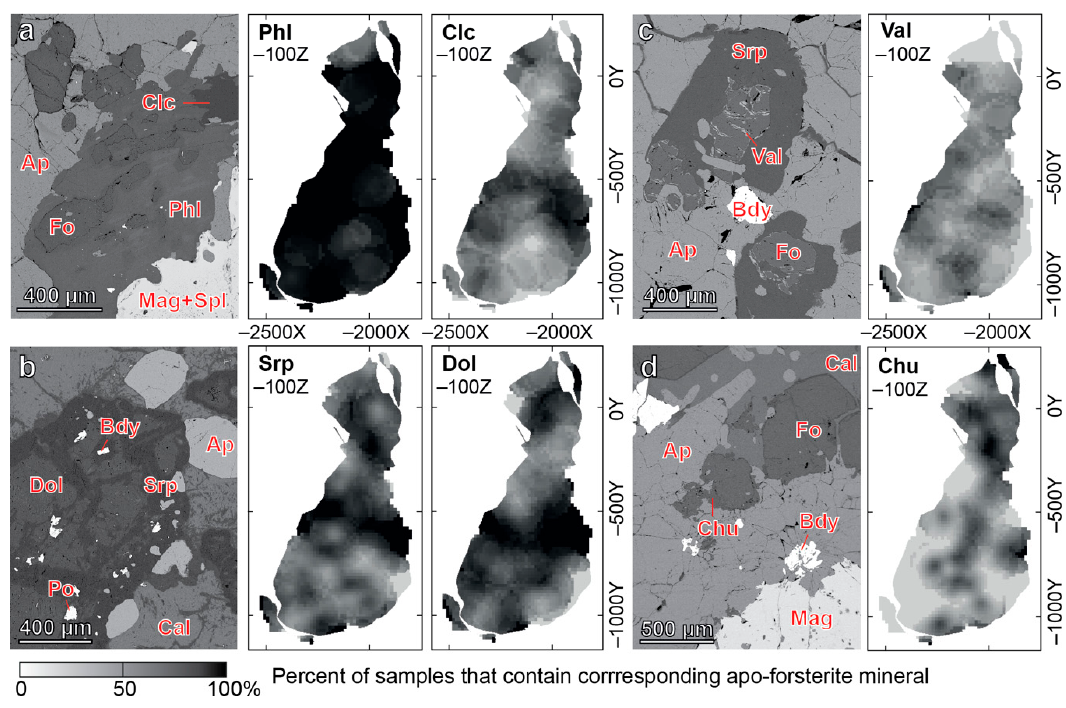
Figure 6. Relation of apo-forsterite phlogopite, clinochlore, serpentine, dolomite, valleriite and clinohumite with forsterite and distribution of these minerals within the Kovdor baddeleyite-apatite- magnetite deposit at horizon − 100 m. BSE-images: ( a ) MAF phoscorite 992/0.9; ( b ) AF phoscorite 970/93.1; ( c ) AF phoscorite 966/165.1; ( d ) MAF phoscorite 986/82.2. Mineral abbreviations see in the Section